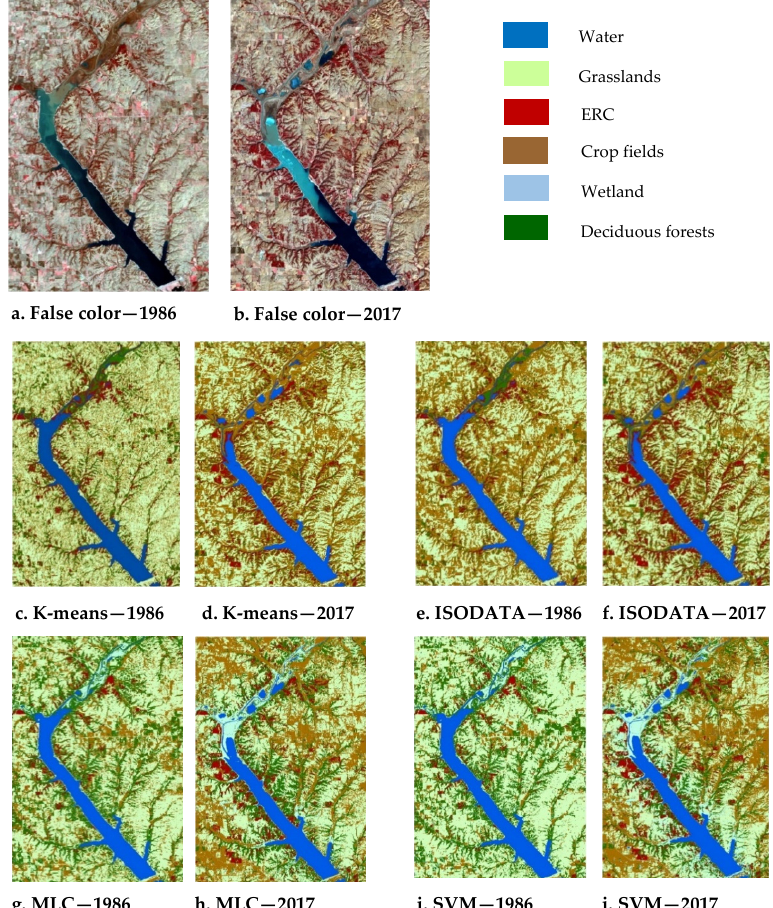
Figure 2. False color composite of the study area surrounding the Tuttle Creek reservoir (SA1) in ( a ). 1986 and ( b ). 2017. K ‐ means clustering classification products: ( c ). 1986 and ( d ). 2017. ISODATA clustering classification products: ( e ). 1986 and ( f ). 2017. Maximum Likelihood classification products: ( g ). 1986 and ( h ). 2017. Support Vector Machines (SVM) classification products: ( i ). 1986 and ( j ). 2017.